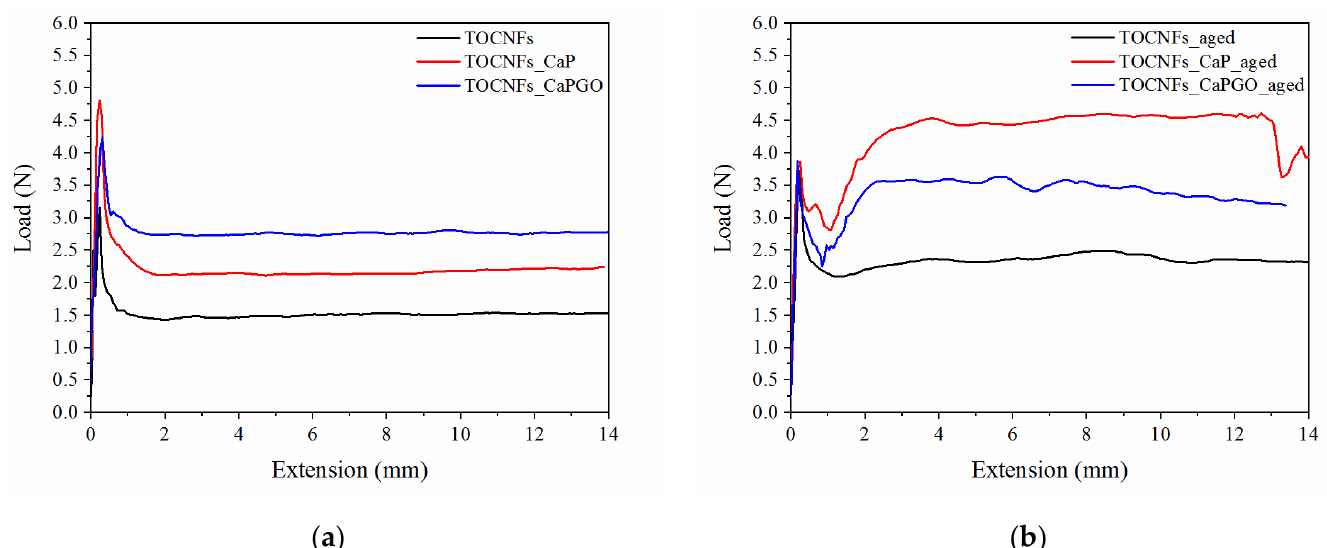
Figure 3. Injectability test: comparison between: ( a ) fresh prepared samples and ( b ) 48 h aged samples. TOCNFs (black line), TOCNFs_CaP (red line) and TOCNFs_CaPGO (blue line) were extruded through a 18 G needle at 20 °C at a crosshead speed of 0.6 mm s − 1 (2.28 mL min − 1 ) measuring the force needed for the process.